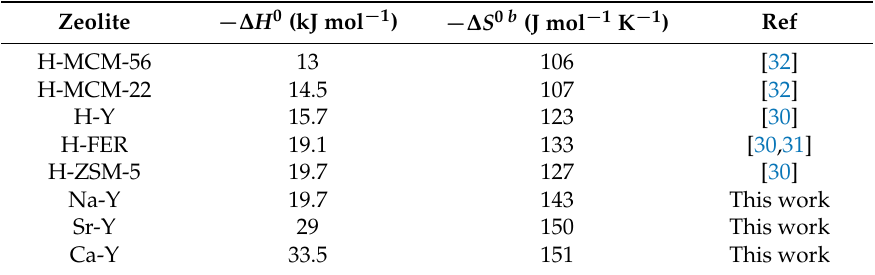
Table 1. Thermodynamic data for nitrogen adsorbed on several zeolites. Error limits for Δ H 0 and Δ S 0 are ±2 kJ mol − 1 and ±10 J mol − 1 K − 1 , respectively.